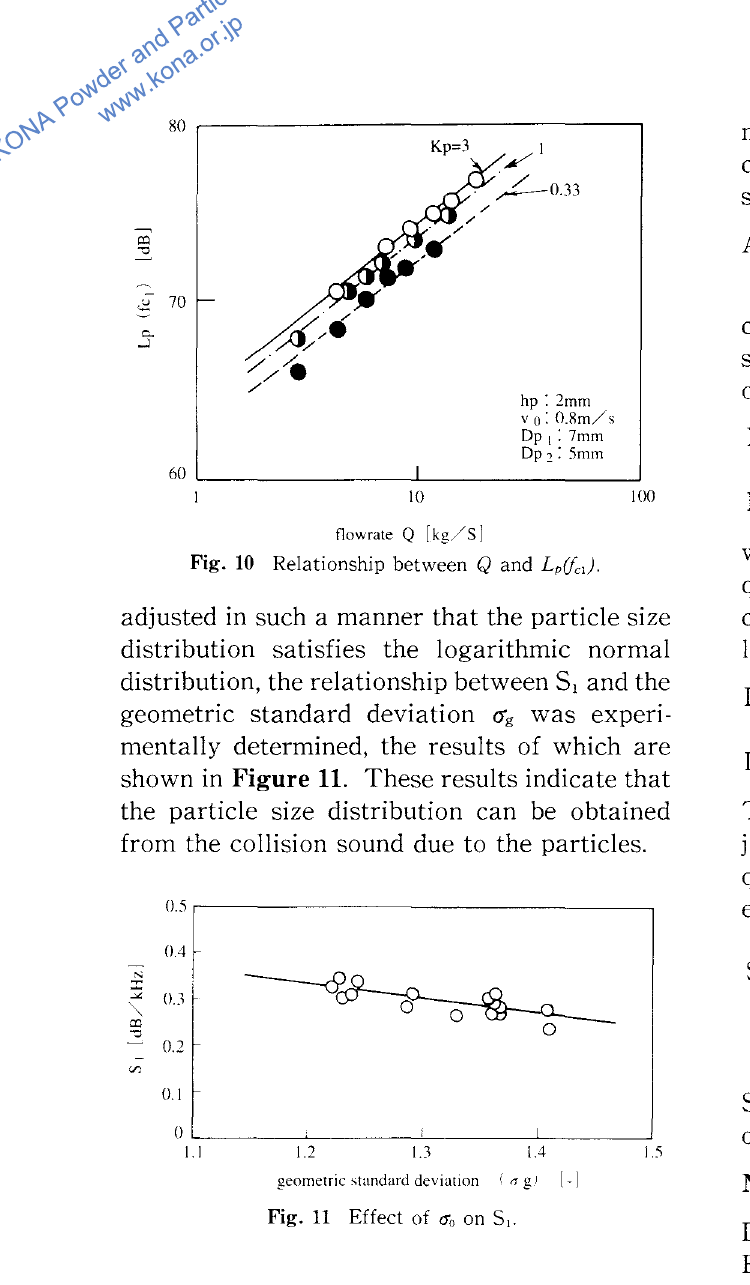
Fig. 11 Effect of <1